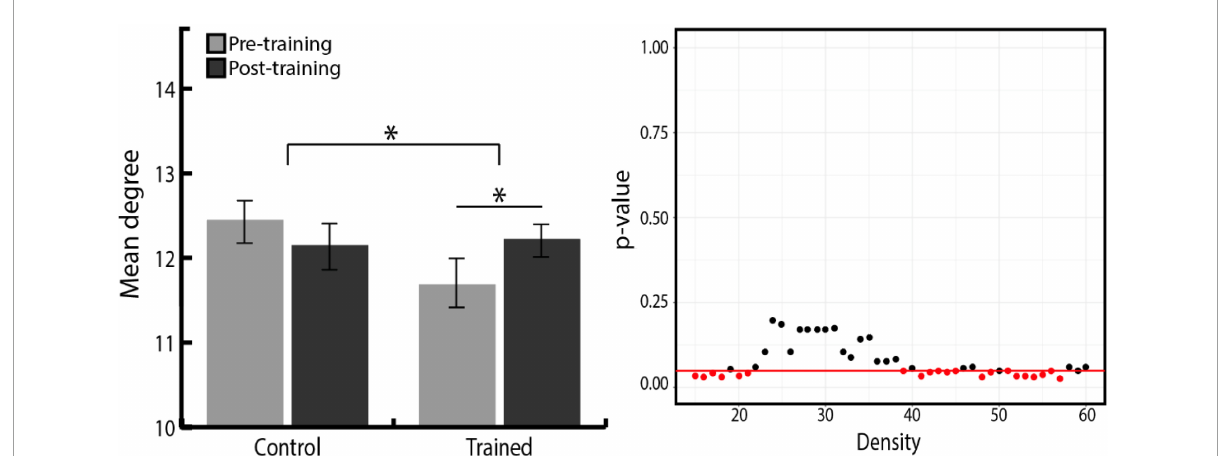
FIGURE4 (Left) Density-averaged CON degree in both groups, before and after training. Density-averaged CON degree significantly increased in the training group compared with the control group (* p < 0.05). Paired t -tests showed that the CON degree significantly increased in the training group. There was no significant difference between the two groups in initial CON degree ( p = 0.054). Error bars indicate the SEM. (Right) P -value distribution for Group × Time ANOVA of the CON degree across network densities. The red line indicates a p -value of 0.05, and red dots indicate the densities at which the difference in the degree change between two groups is significant.